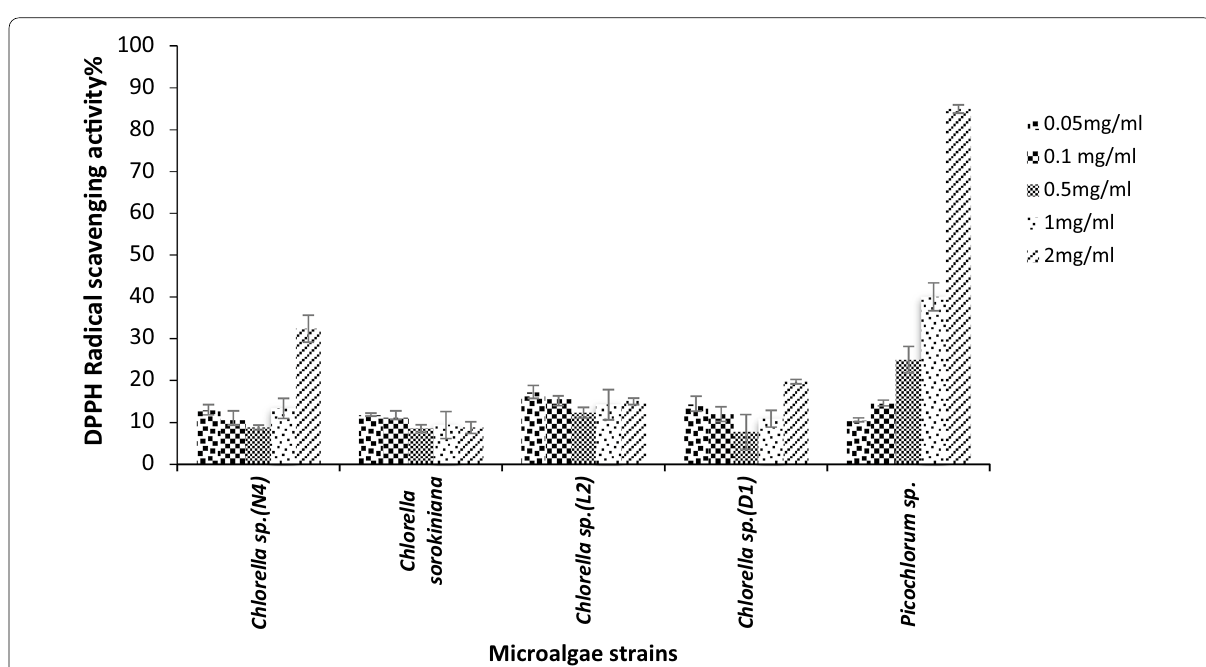
Fig. 6 Antioxidant activity, 1,1-diphenyl-2-picrylhydrazyl (DPPH) radicals scavenging activity by sPS extracted of various microalgae strains